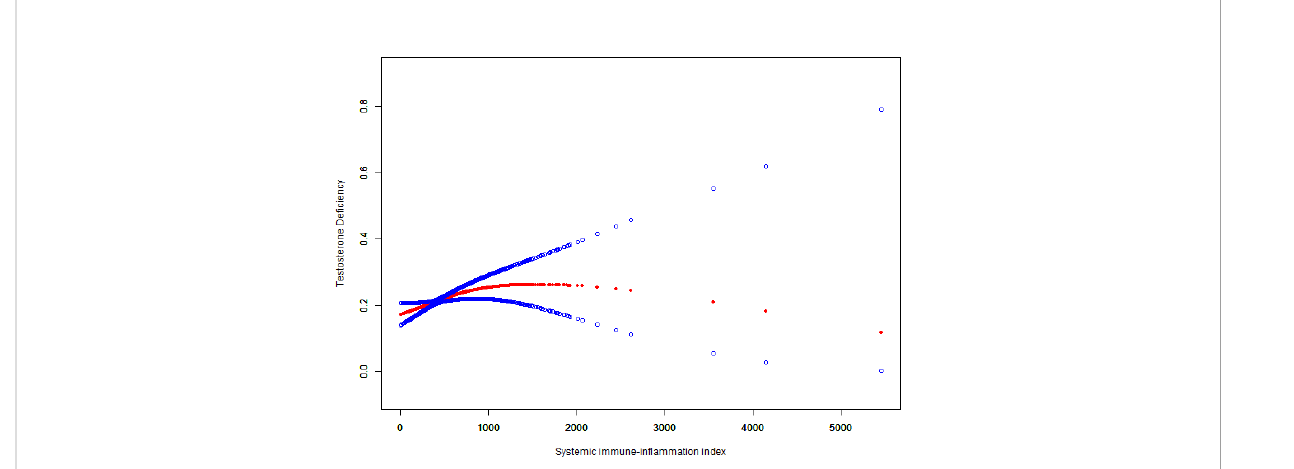
FIGURE 2 The Nonlinear relationship between SII and TD incidence rate. A smooth curve fi tting between variables is represented by the solid red line. The 95% con fi dence interval of the fi t is indicated by the blue line.The values were adjusted for age, race, BMI, coronary artery disease, heart failure, stroke, smoking status, alcohol consumption, education level, hypertension, diabetes, triglycerides, urine creatinine, and serum total